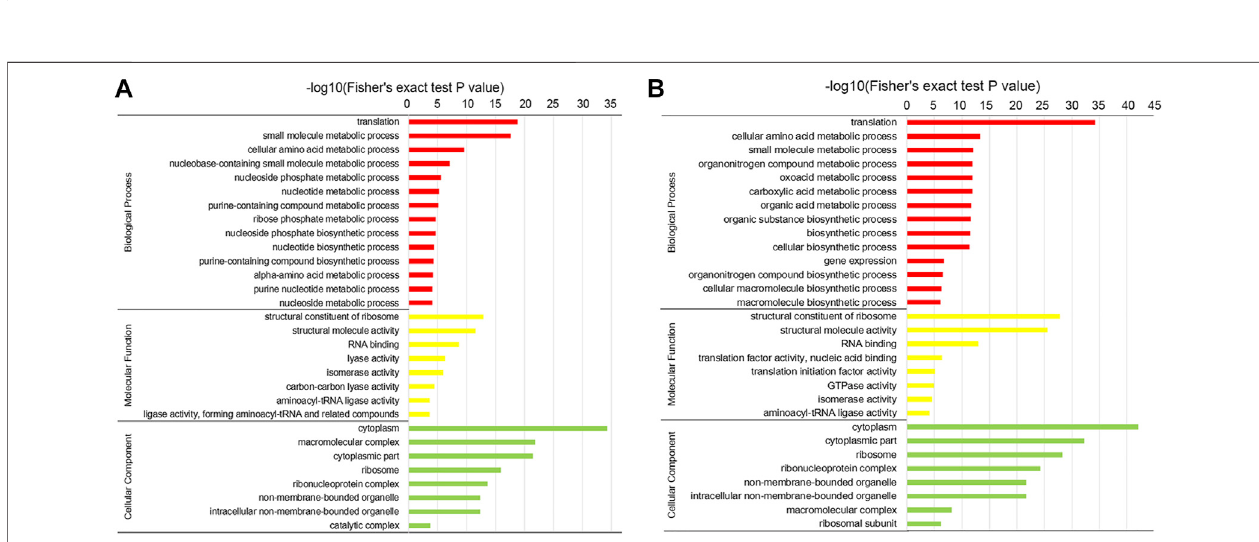
FIGURE 4 | GO enrichment of the crotonylated proteins. Enrichment analysis of crotonylated proteins in the (A) conidial stage and (B) mycelial stage.